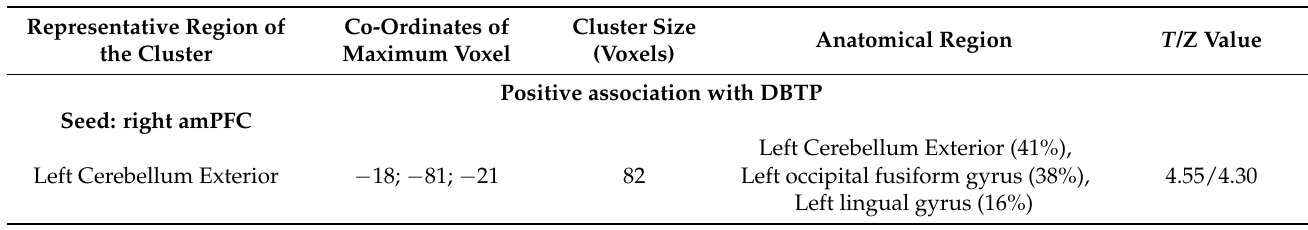
Table 1. Resting state functional connectivity involving DMN core seeds showing significant correla- tions with